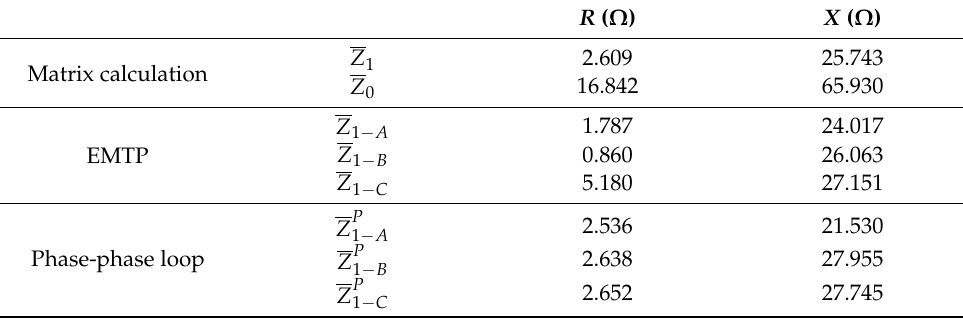
Table 2. Calculation results of symmetrical components (per phase as well).